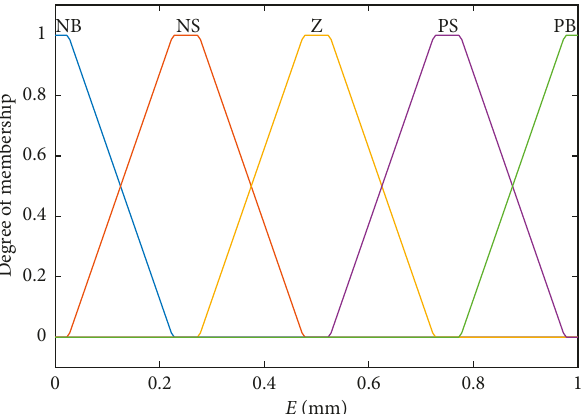
Figure 5: Trapezoid membership function.